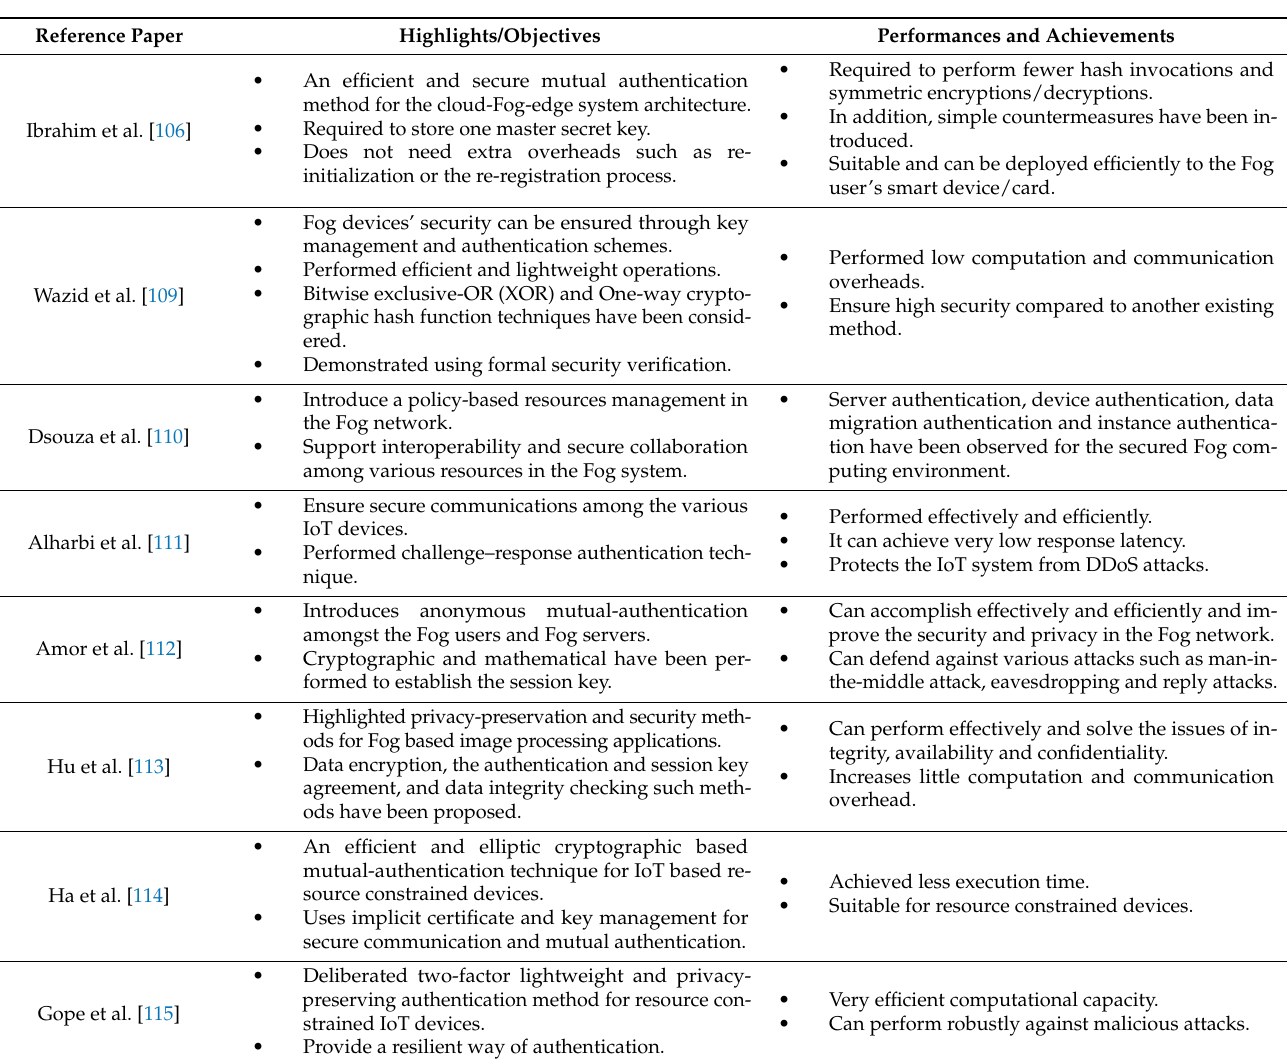
Table 8. The summary of Authentication issues in Fog environments from major survey papers. Reference Paper Highlights/Objectives Performances and